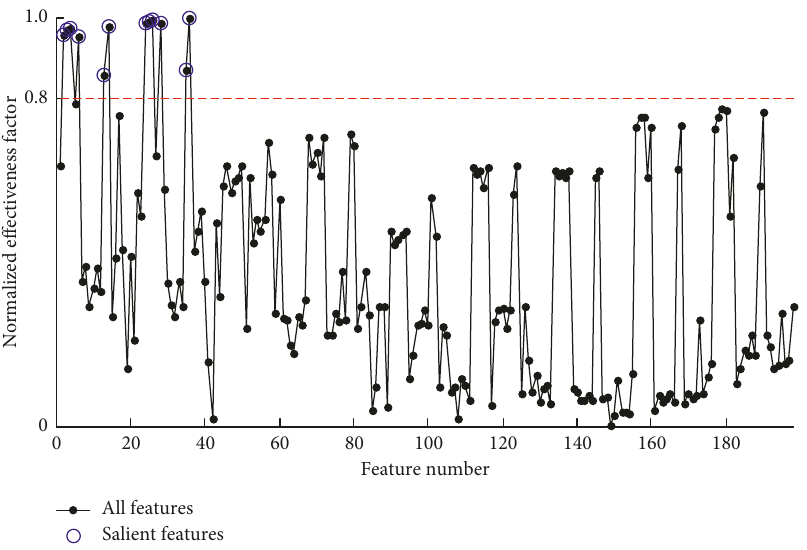
Figure 18: Salient features when EMD is applied in experiment